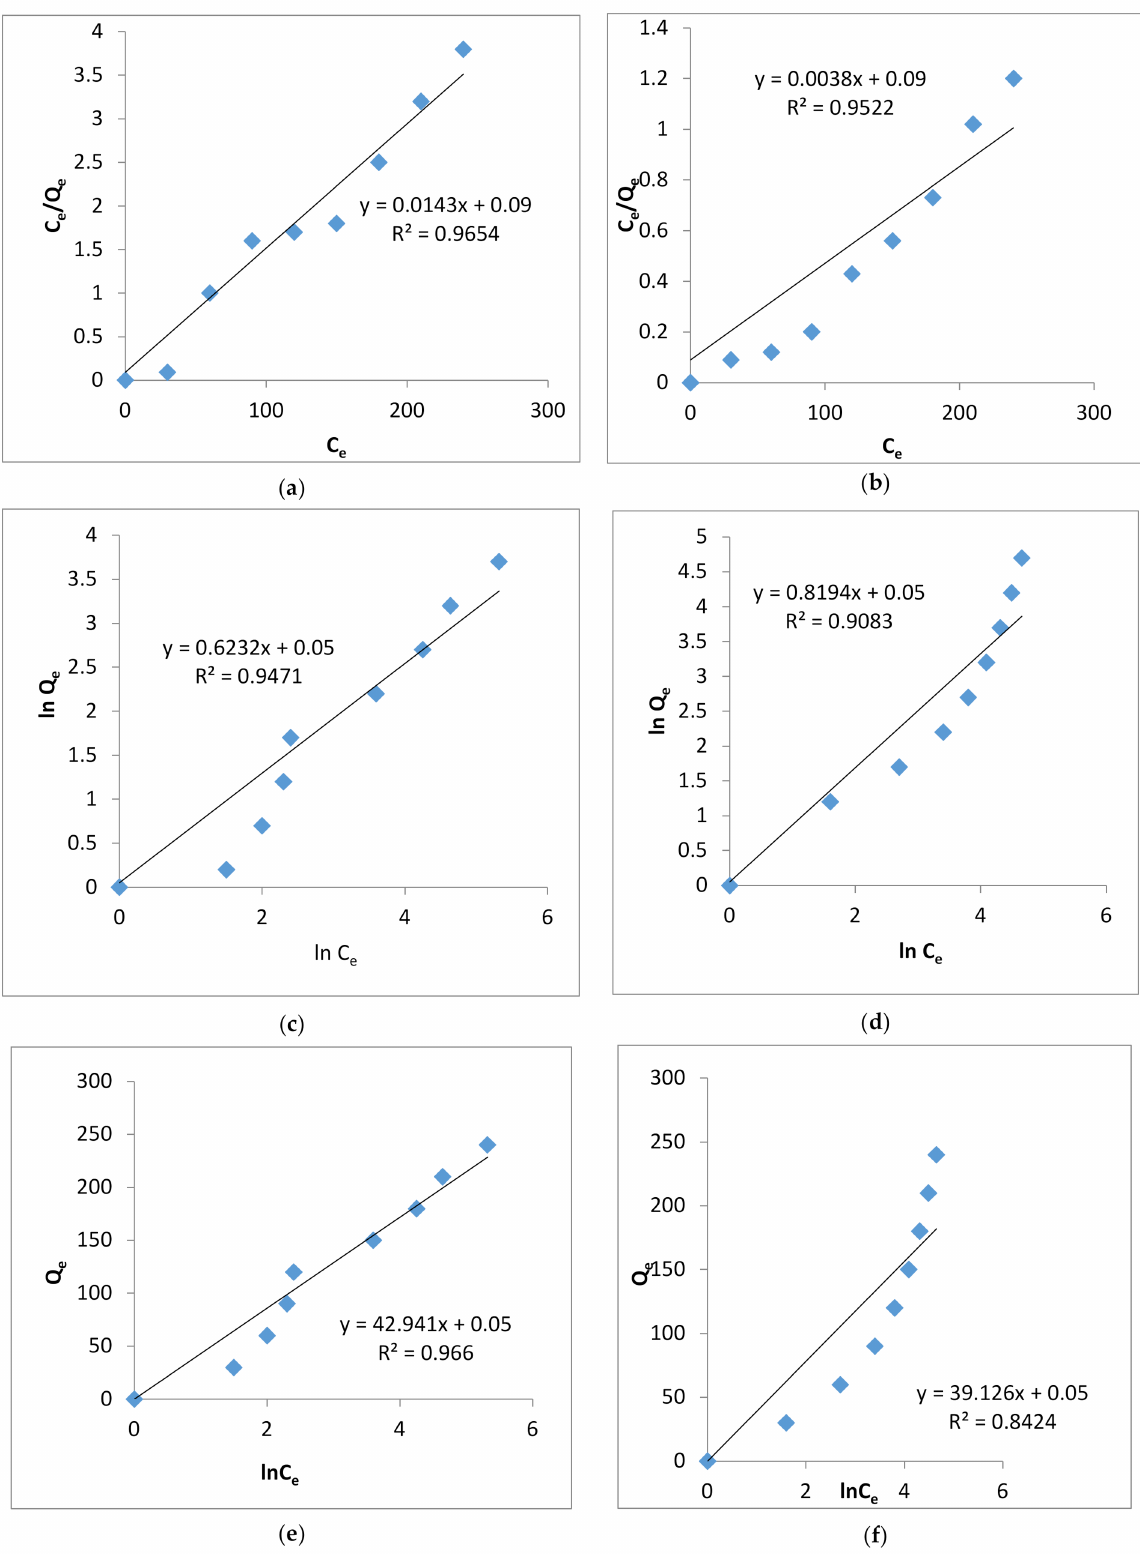
Figure 10. Langmuir isotherm model for adsorption of ( a ) Acid Red 4 ( b ) MB; Freundlich isotherm model for adsorption of ( c ) acid red 4 ( d ) MB; Temkin isotherm model for adsorption of ( e ) acid red 4 ( f ) Methylene